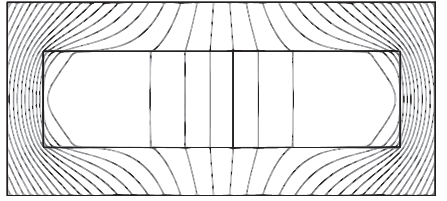
FIG. 9. Flux applied to a thin circular disk transverse to an > H applied field where H . The field breaks in at the edges a a j entry < H first at H . Above H the flux lines will move to edge a j entry a j entry the center of the sample, which is the position with lowest line tension. Redrawn after [15].